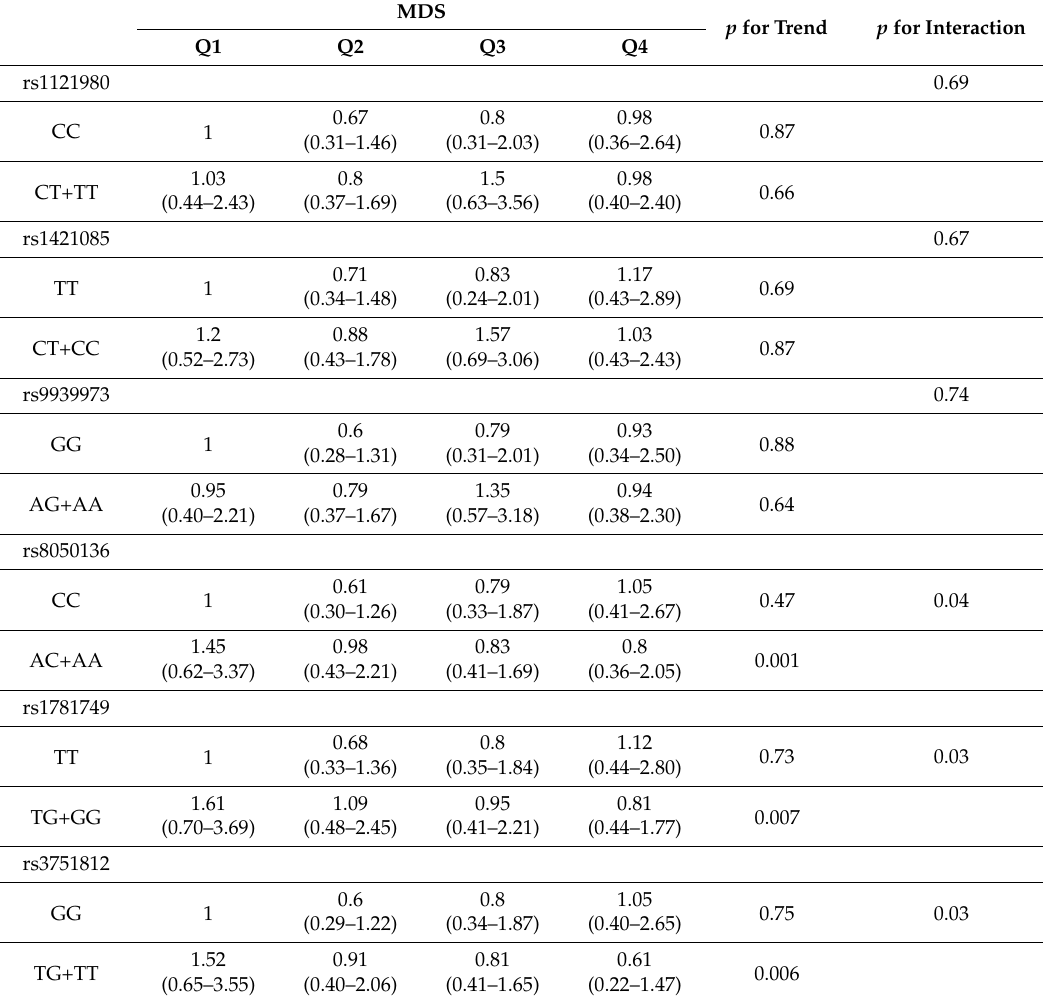
Table 5. Adjusted ORs (95%CI) a for high waist to hip ratio according to quartiles of MDS by FTO SNP genotypes (Tehran Lipid and Glucose